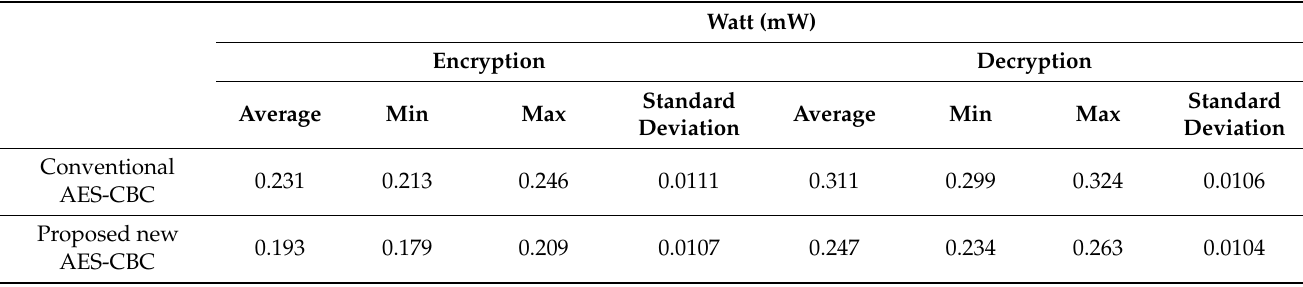
Table 7. Average power consumption and standard deviation during encryption and